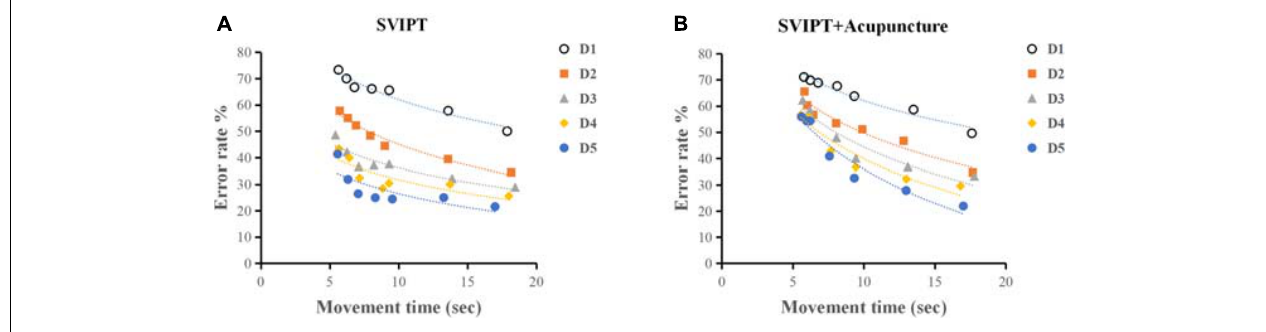
TABLE 2 | Learning skill index for 5 days in the SVIPT and SVIPT-acupuncture groups. SVIPT group SVIPT-acupuncture group